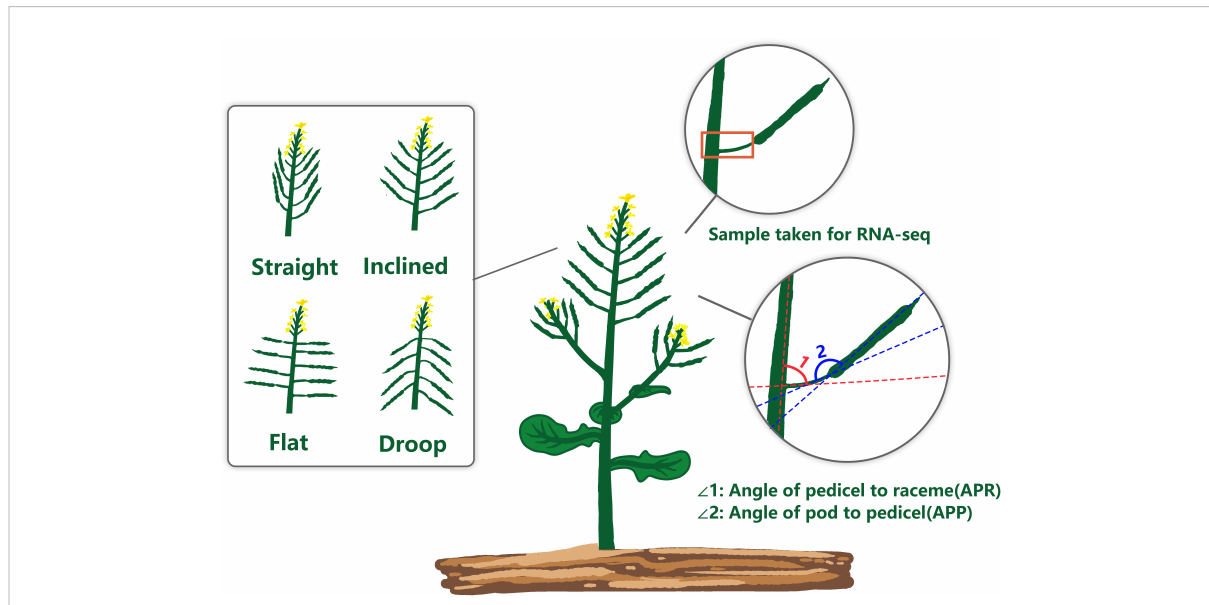
FIGURE 1 Schematic diagram of the rapeseed pod orientation showing two indices of pod orientation; APR, Angle of pedicel to raceme; and APP, Angle of the pod to the